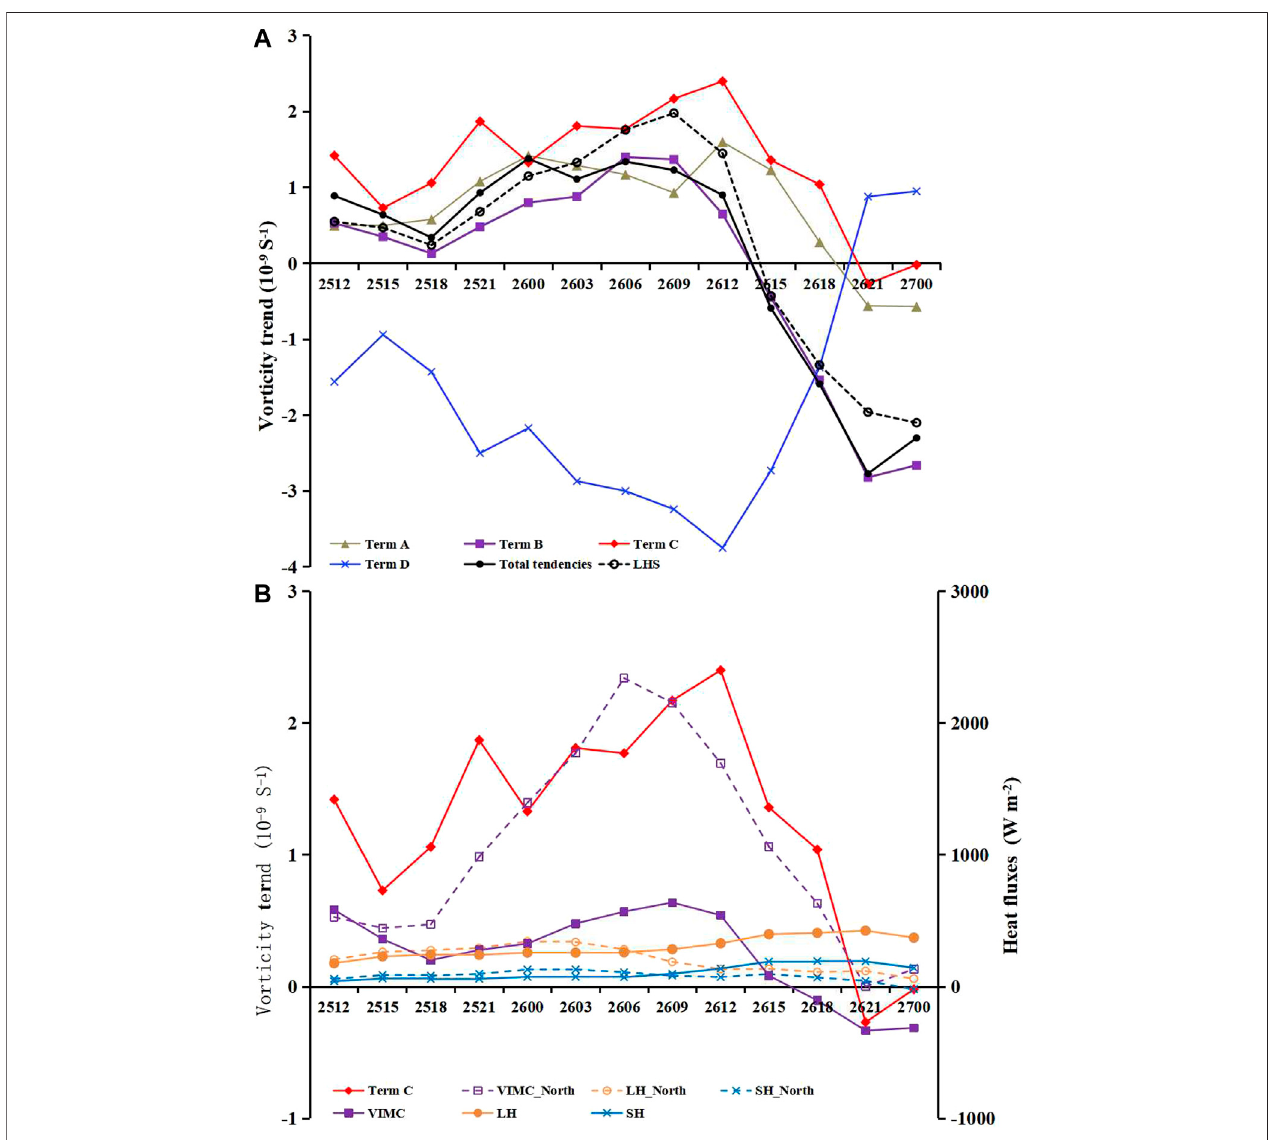
FIGURE 6 | (A) Evolution of the area mean cyclonic-vorticity advection (Term A, brown), warm-air advection (Term B, purple), diabatic heating (Term C, red) , adiabaticheating(TermD, blue) ,totaltendencies (black) andthe950-hPageostrophicvorticitytendency (dashed, LHSof Eq.2 ).Theareais10 ° × 10 ° andmovedwith theSEC asthecenter. (B) Evolutionoftheareameandiabaticheating(TermC, red) ,surfacesensibleheat fl uxes(SH, blue) ,surfacelatent heat fl uxes(LH, orange) and verticallyintegratedmoistureconvergence(VIMC,convertedtounitofWm − 2 , purple) .The “ _North ” indicatesthenorthhalfareamean(10 ° longitudes × 5 ° latitudes) over the north of SEC